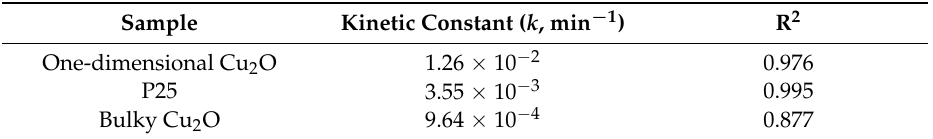
Table 1. Degradation parameters of kinetic constant ( k , min − 1 ) and R 2 using different photocatalysts under visible light irradiation.